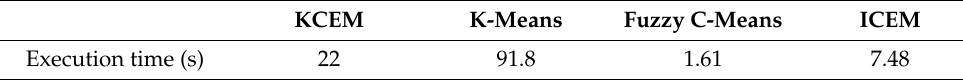
Table 7. Mass tumor: Average execution time of each method for 14 cases.